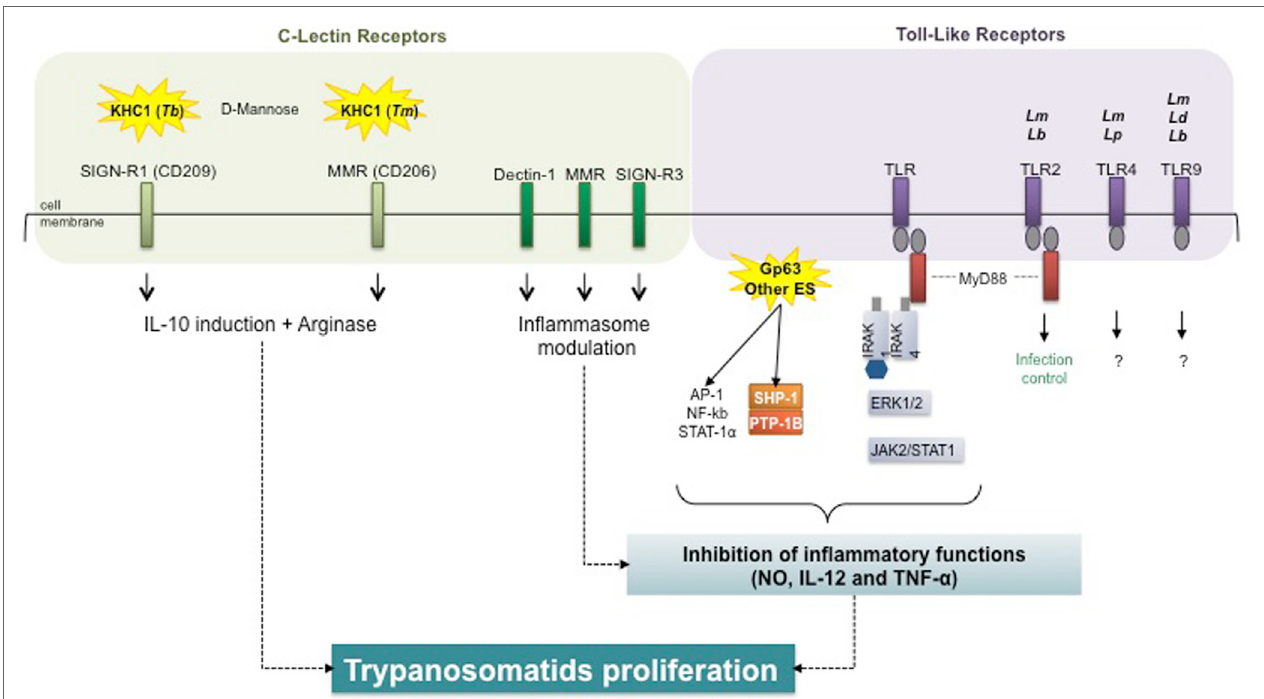
FiGURe 5 | Host receptors in trypanosomatid-mediated arginase modulation. Trypanosomatids and virulence factors: Tb , Trypanosoma brucei; Tm, T. musculi; Lm , Leishmania major ; Lb, L. braziliensis; Lp, L. pifanoi ; Ld, L. donovani ; Gp, glycoprotein; ES, excreted–secreted. Macrophage receptors: SIGN-R1, specific intercellular adhesion molecule grabbing non-integrin receptor 1; MMR, macrophage mannose receptor; TLR, toll-like receptor. Signal transduction molecules: MyD88, myeloid differentiation primary response 88; IRAK, interleukin-1 receptor-associated kinase; AP, activator protein; NF- κ B, nuclear factor-kappa B; STAT, signal transducers and activators of transcription; SHP, Src homology region 2 domain-containing phosphatase; PTB, protein tyrosine phosphatase; ERK, extracellular signal-regulated kinase; JAK, Janus kinase (or just another kinase). Inflammatory markers: NO, nitric oxide; IL, interleukin; TNF, tumor necrosis